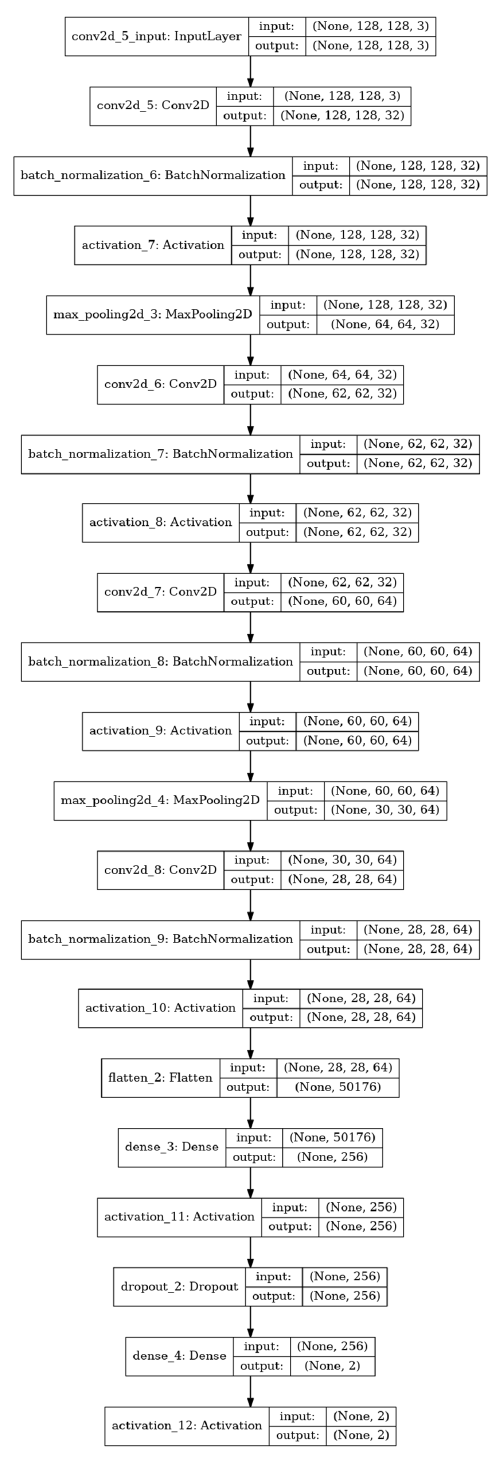
Figure 10. Summary of the CNN model.